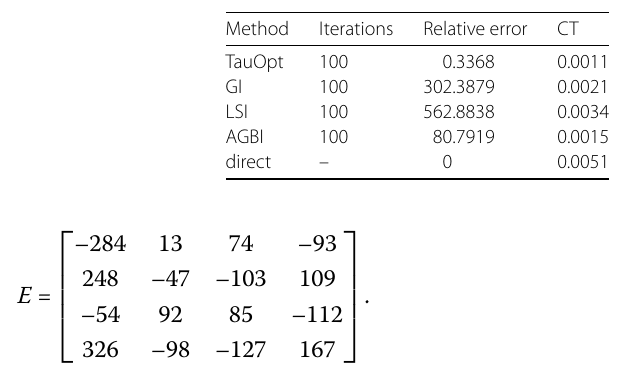
Table 3 Relative errors and CTs for Ex.